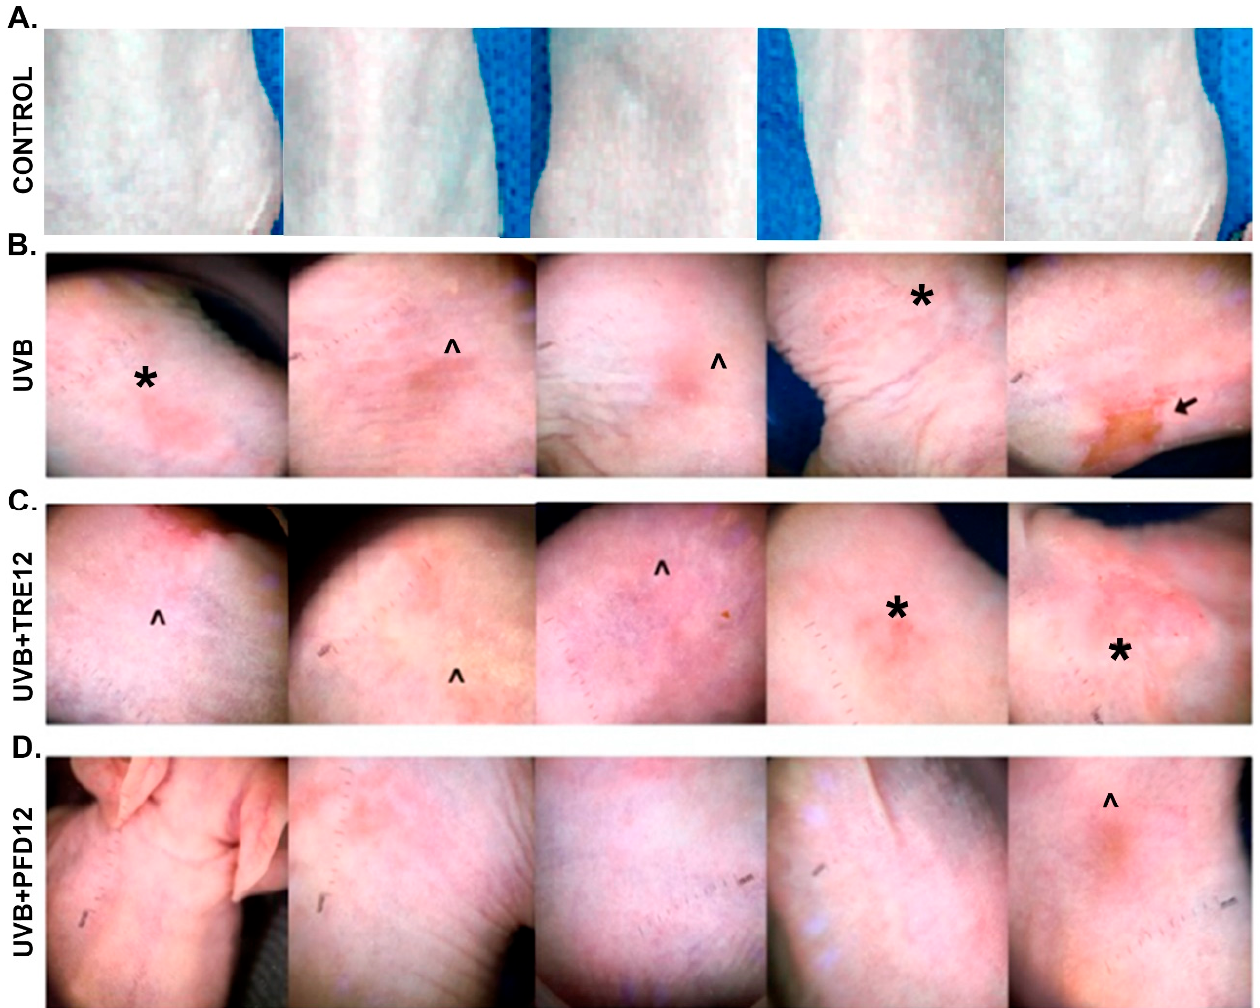
Figure 2. Dermoscopic analysis of skin lesions. ( A ) Group of control mice, without exposure to UVB irradiation. ( B ) UVB group, mice exposed to UVB irradiation, examination of the dorsal area revealed inflammatory skin lesions such as macules (*) and ulceration ( ↑ ); and non-inflammatory skin lesions such as scales (ˆ). ( C ) UVB + TRE12 group, mice treated with TRE (0.05% Retin-A ® cream) inflammatory skin lesions such as macules (*) and ulceration ( ↑ ) are also observed; and non-inflammatory skin lesions such as scales (ˆ). ( D ) UVB + PFD group, mice treated with PFD (8% gel), in which only few, non-inflammatory, scale-like skin lesions were developed (^).